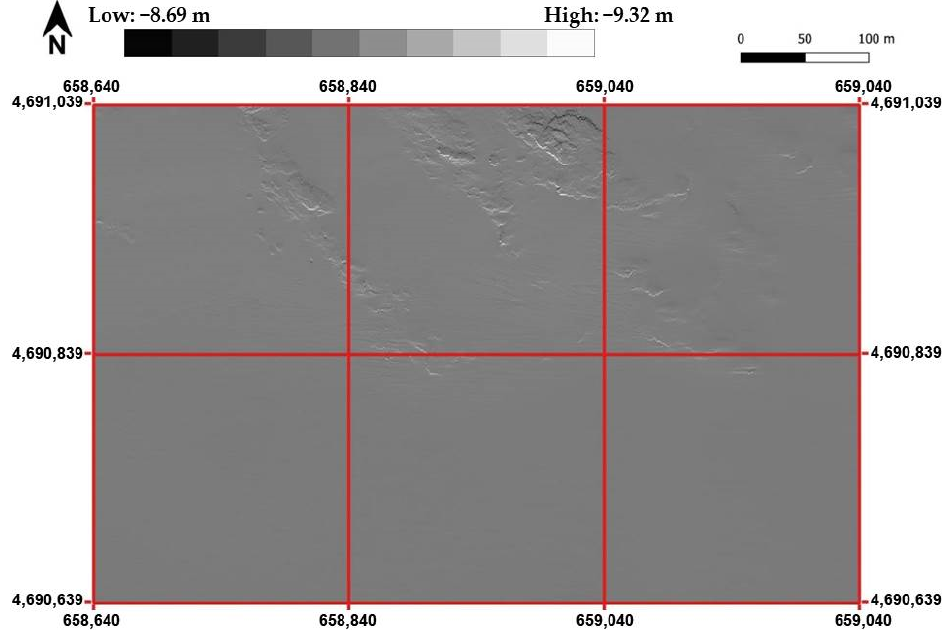
Figure 9. Image of the differences of MBD values along y direction.